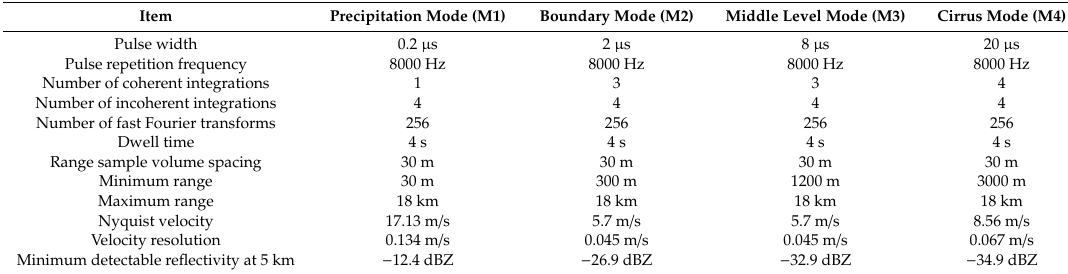
Table 1. Major parameters of the four operational